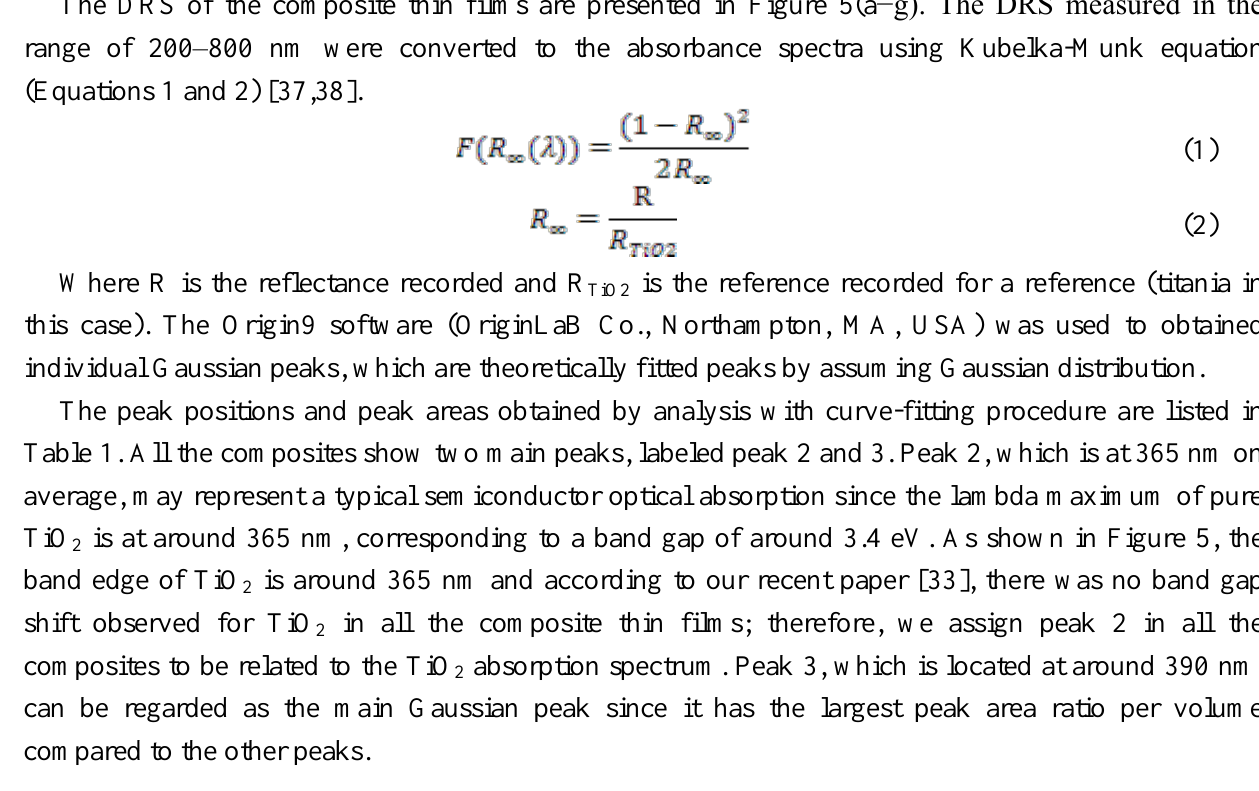
composite thin films 2